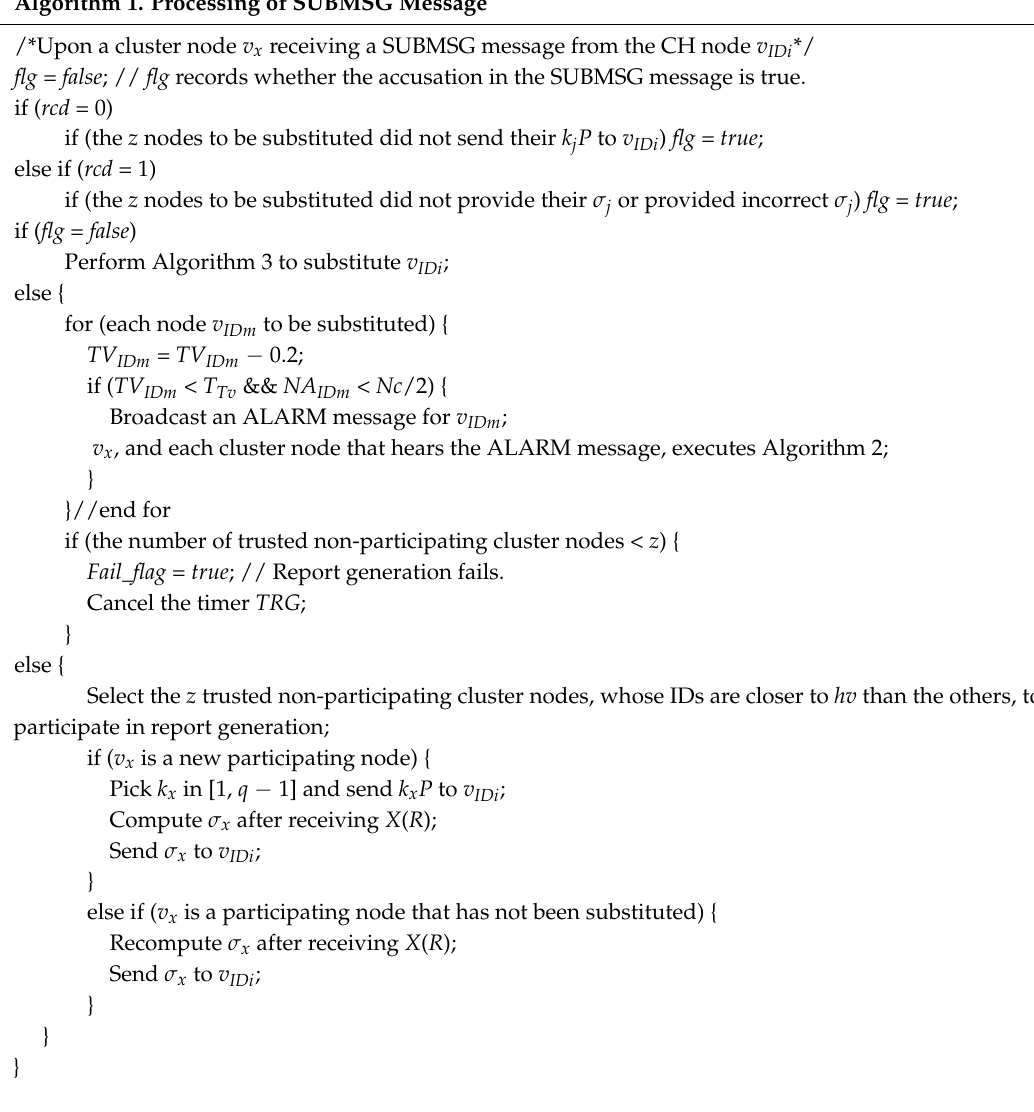
Algorithm 1. Processing of SUBMSG